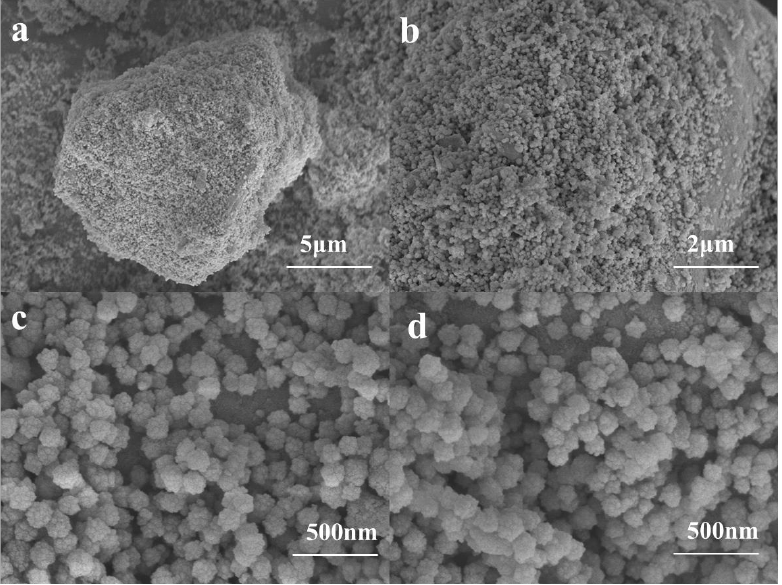
Figure 4. SEM analysis results of the ZCS/1CSO sample, the overall morphology of particles ( a ), the particle surface morphology ( b ), the micro details of particle surface ( c , d )